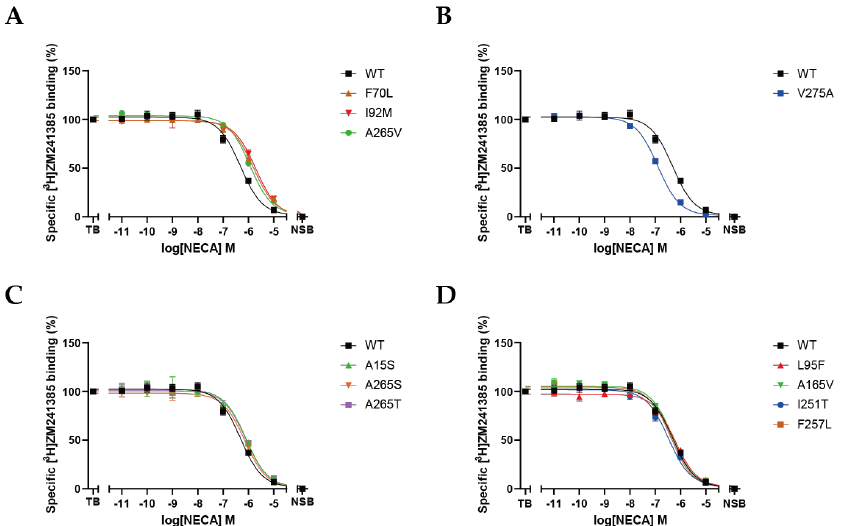
Figure 4. Displacement of [ 3 H]ZM241385 performed by increasing the concentrations of NECA in wild-type and mutant A 2A ARs. Compared with wild-type A 2A AR, three mutants displayed lower affinity for NECA ( A ), V275A-A 2A AR displayed higher affinity for NECA ( B ), three mutants displayed slightly different affinity for NECA ( C ), and four mutants displayed similar affinity for NECA ( D ). Data are shown as mean ± SEM of three independent experiments, each performed in duplicate.